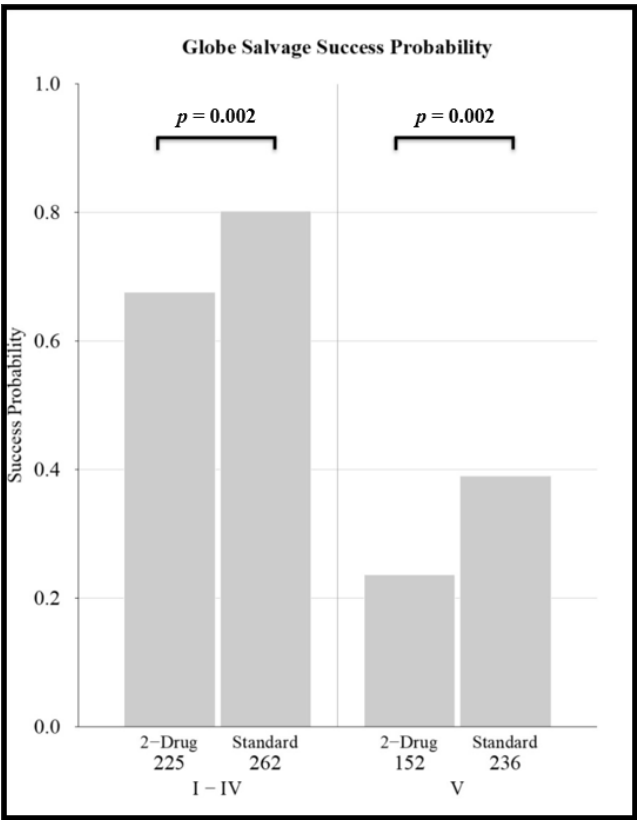
Figure 3. Comparison of globe salvage probability for “reduced” (2-drug regimen) vs. “standard” intravenous chemotherapy regimens for less advanced (Reese–Ellsworth groups I–IV) and more advanced (Reese–Ellsworth group V)